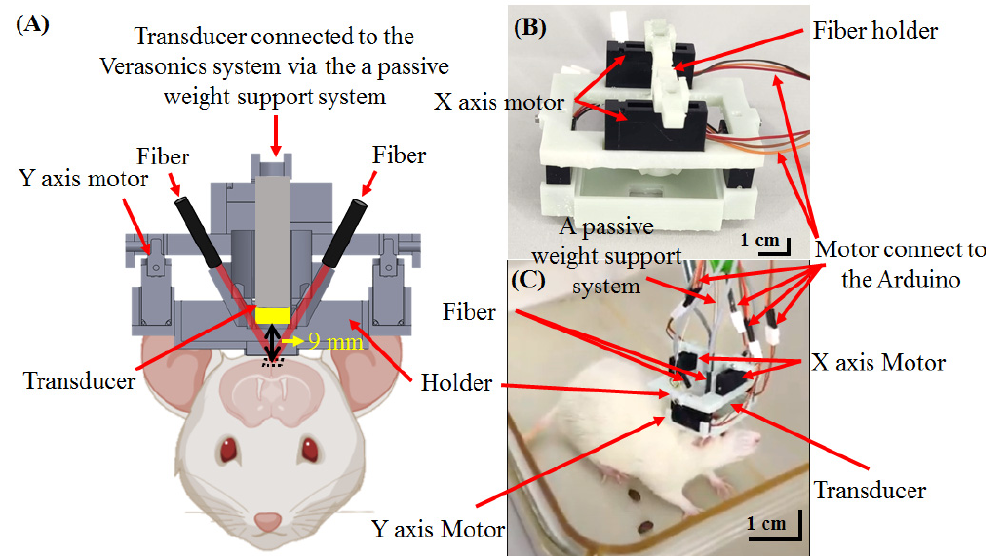
Figure 5. Schematic diagram of the cross-sectional view of the developed hmPAI system, describing all parts in detail, including the placement of the bracket, optical fiber, probe, x / y -axis motors, and Arduino device and the actual location on the rat. ( A ) Schematic showing the laser light path and transducer orientation. ( B ) Photograph of the assembled holder. ( C ) Photograph of the assembled system with transducer and fiber mounted on the head of a rat.